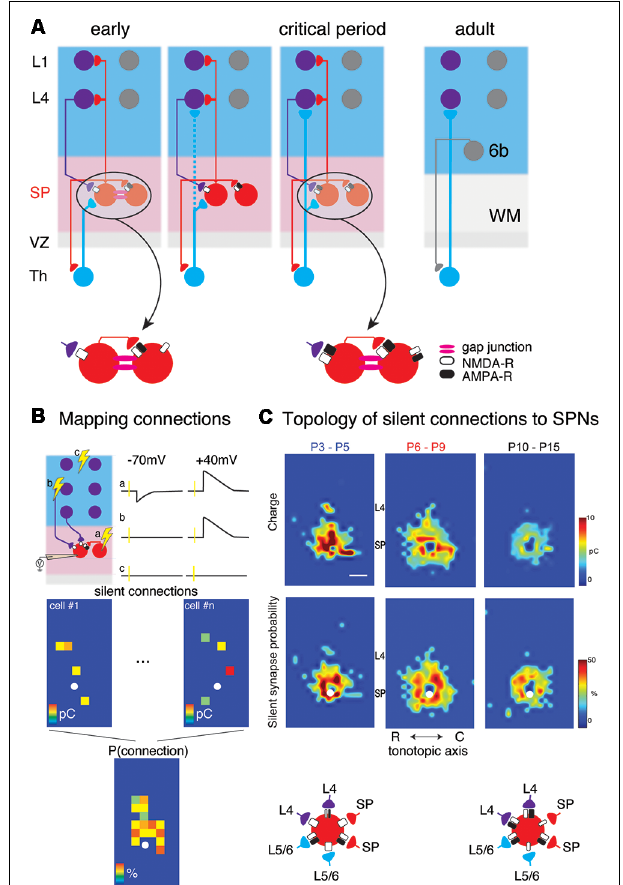
FIGURE 1 | (A) Changing circuits between thalamus (Th), subplate (SP) and cortical layers 4 (L4) and 1 (L1). Insets show the existence of NMDA-R only “silent” synapses at early ages. (B) Cartoon illustration mapping of connections to subplate neurons (SPNs) via laser-scanning photostimulation (LSPS). Patch clamp recordings in voltage clamp are made from SPNs and locations are selectively stimulated. The SPN is recorded at − 70 mV and +40 mV membrane potential at each stimulation location. Traces (a–c) indicate three potential outcomes of stimulation at the respective locations. (a) Stimulation of presynaptic locations that were connected to the SPN with AMPA and NMDARs resulted in excitatory postsynaptic currents (EPSCs) at both − 70 mV and +40 mV. (b) Stimulation of presynaptic locations that were connected to the SPN with only NMDARs resulted in EPSCs at only +40 mV. (c) Stimulation of presynaptic locations that were not connected to the SPN resulted in no EPSCs at either − 70 mV and +40 mV. Bottom shows calculating the spatial connection probability from maps of NMDAR-only connections (e.g., sites similar to site b ). White circle indicates soma location of SPN. Maps of individual neurons are aligned to the soma and the probability of observing an EPSC is calculated for all relative spatial locations. (C) Changing topology of silent synapses over development. Shown are average connection probability and mean charge maps from LSPS experiments (from Meng et al., 2014). Cartoon below summarizes these data. At early ages, silent synapses are present between L4, L6/6, SP and SP and have a large synaptic strength. Silent synapses are most abundant at P6-P9 and at older ages, the strength of silent synapses has decreased. classes of SPNs have been shown to have dendritic trees